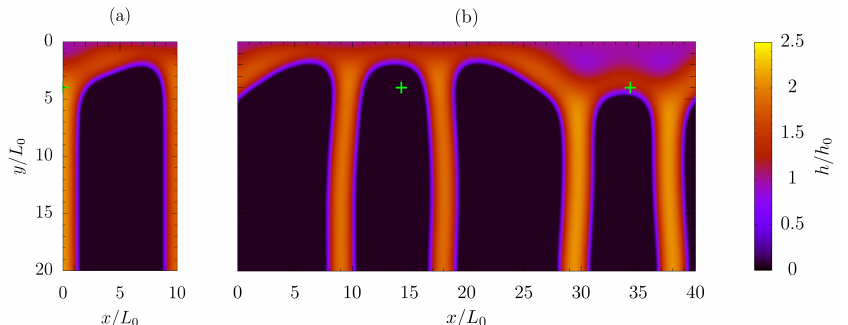
Figure 10. Numerical film thickness solution at T = 125: half periodic length with symmetry boundary conditions through X = 0 and X = L X /2 ( a ); larger computational domain, including 2 contamination spots, with periodic boundary condition through X = 0 and X = 2 L X ( b ). Bo = 0.1, L X = 20, θ s = 60 ◦ (75 ◦ inside the contamination spot), α = 60 ◦